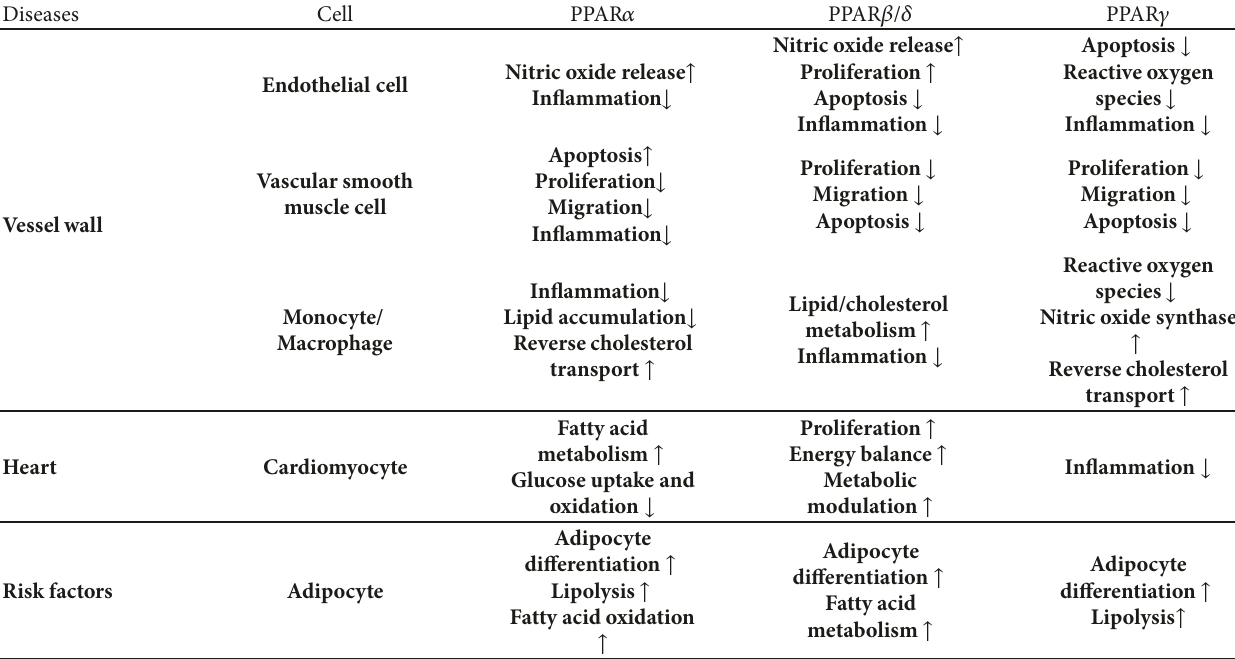
Table 1: The beneficial effects of peroxisome proliferator-activated receptors (PPARs) activation on cardiovascular diseases and risks.